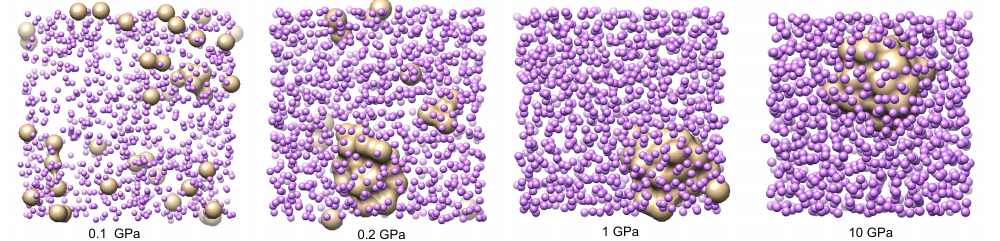
Figure 6. Snapshots of the He-Li mixtures at characteristic pressures: 0.1 GPa, 0.2 GPa, 1 GPa, and 10